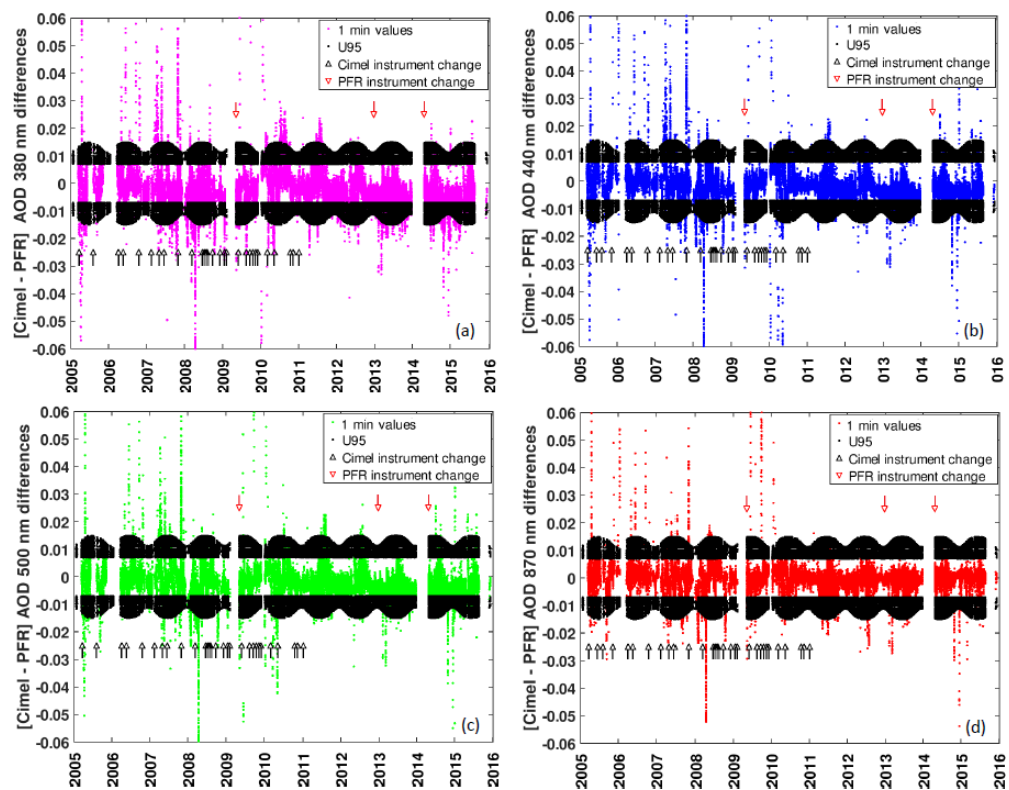
Figure 2. The 1min AOD data differences between AERONET-Cimel (V2) and GAW-PFR for (a) 380nm (70838 data pairs), (b) 440nm (71645 data pairs), (c) 500nm (70833 data pairs) and (d) 870nm (71660 data pairs) for the period 2005–2015. Black dots correspond to the U 95 limits. A small number of outliers are out of the ∼ 0 . 06 AOD difference range. Black arrows indicate a change of reference AERONET-Cimel radiometer and red arrows indicate a change of the GAW-PFR